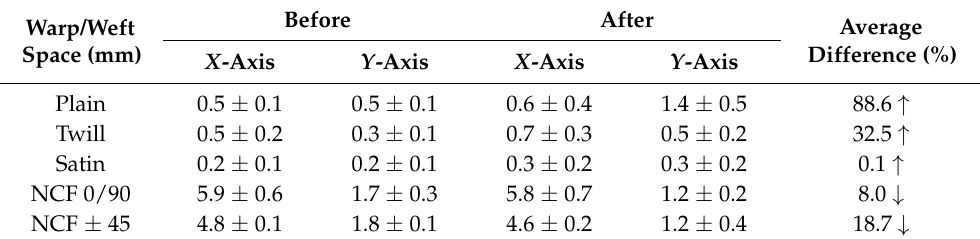
Table 2. Average warp/weft space relation before and after deformation